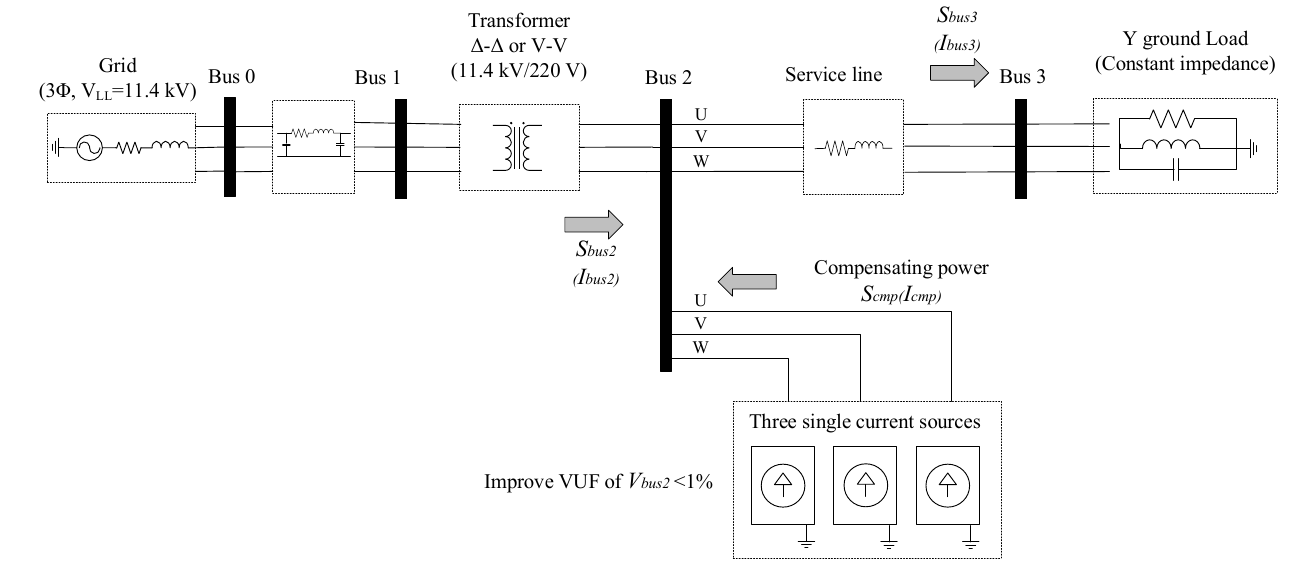
Figure 1. Distribution network and balancing compensating device.